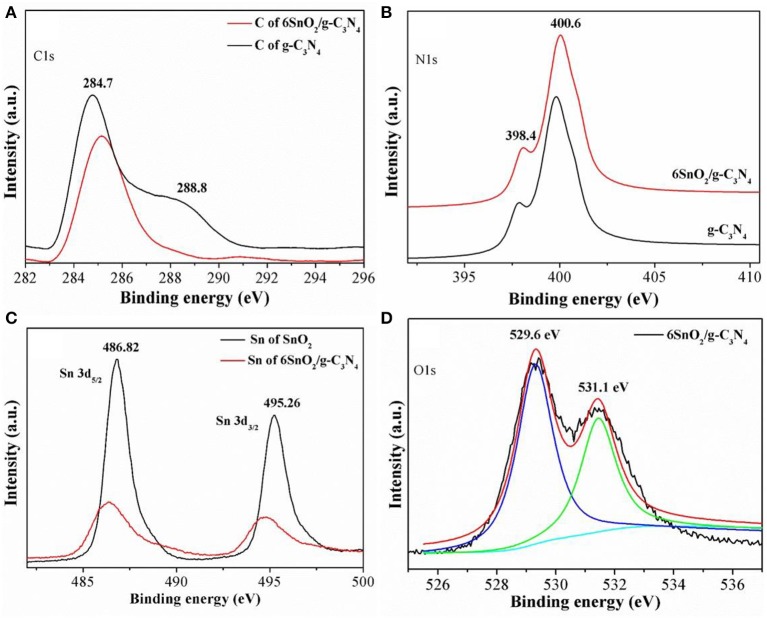
X-ray photoelectron spectra of C1s (A), N1s (B), Sn 3d (C), and O1s (D) of g-C3N4 and SnO2.